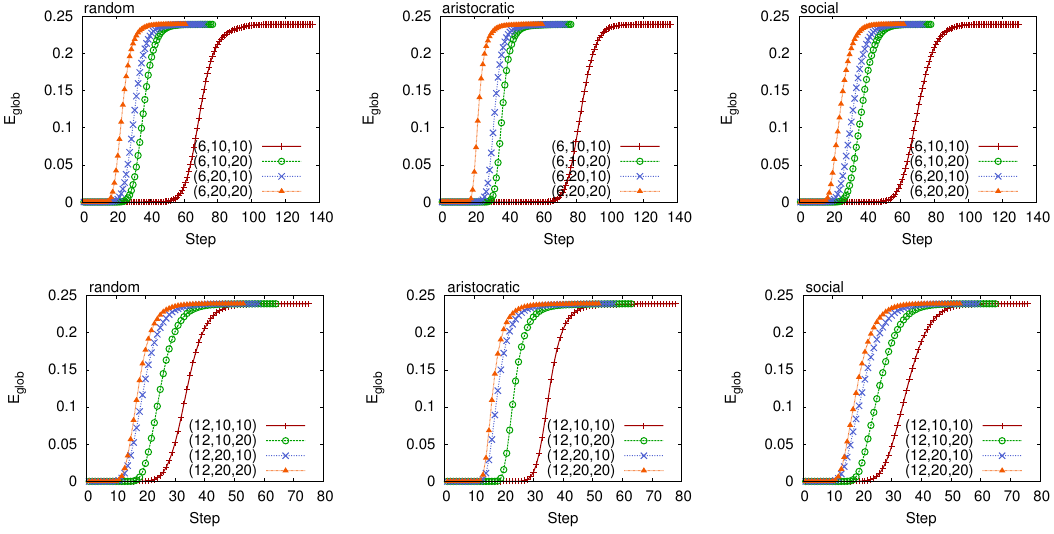
Figure 19. Accelerated analysis with mermaids fixing the number of mermaids to m = 6 and m = 12, random, aristocratic, and social rules. The mermaids’ dynamics evolve according to the preferential model. Communities online social